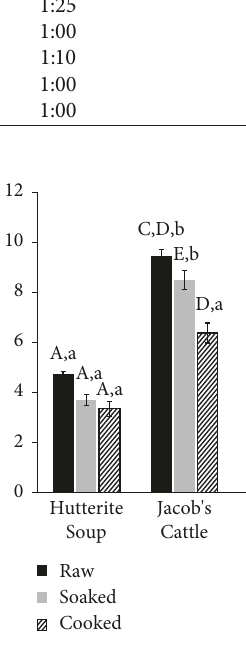
Figure 3: Total phenolics content of raw, soaked, and cooked